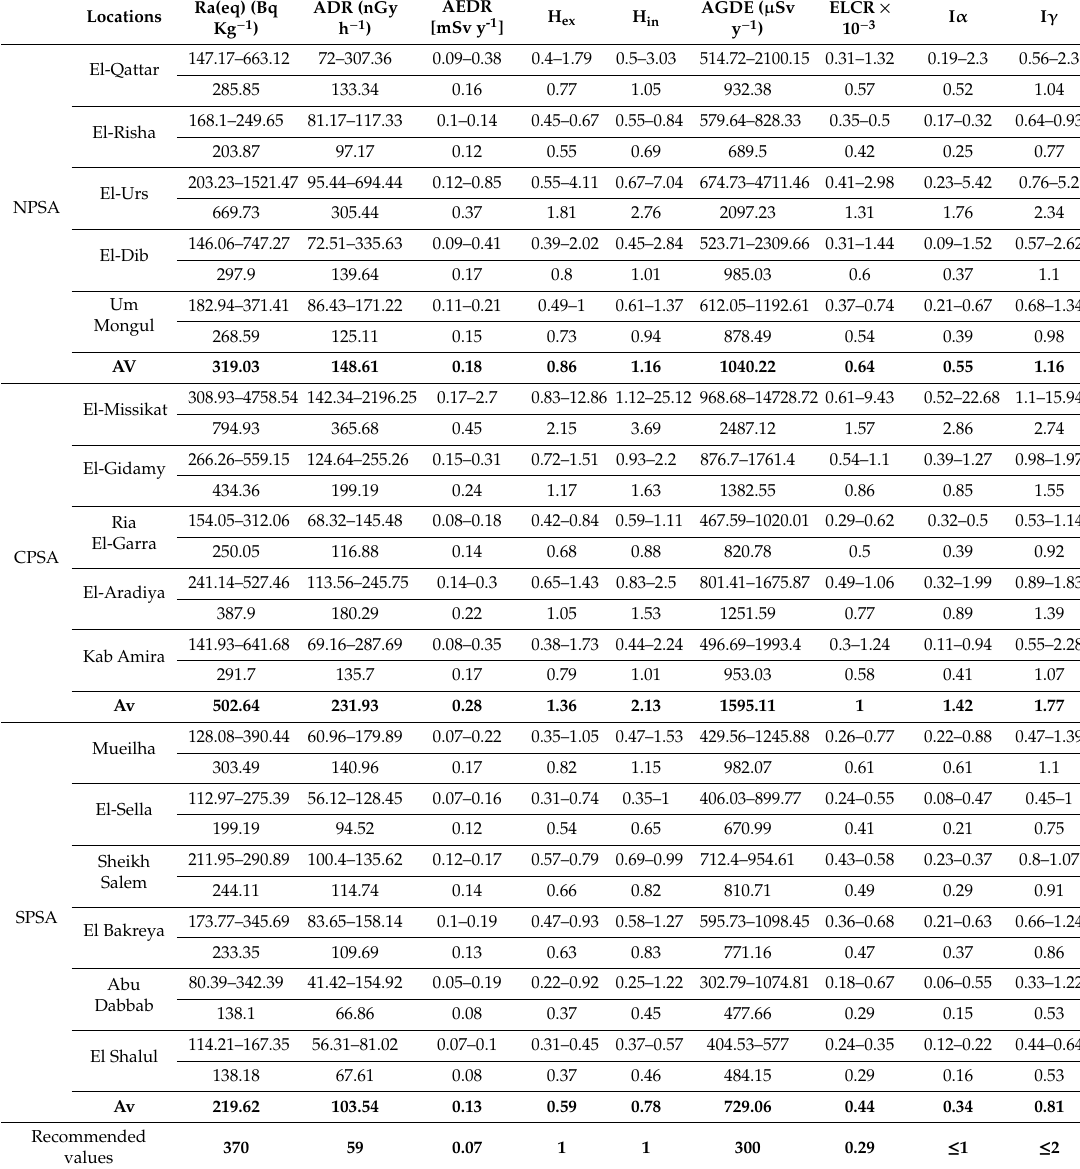
Table 2. Range and mean values for the radiological parameters of the studied granitic samples from the 3 parts of the Eastern